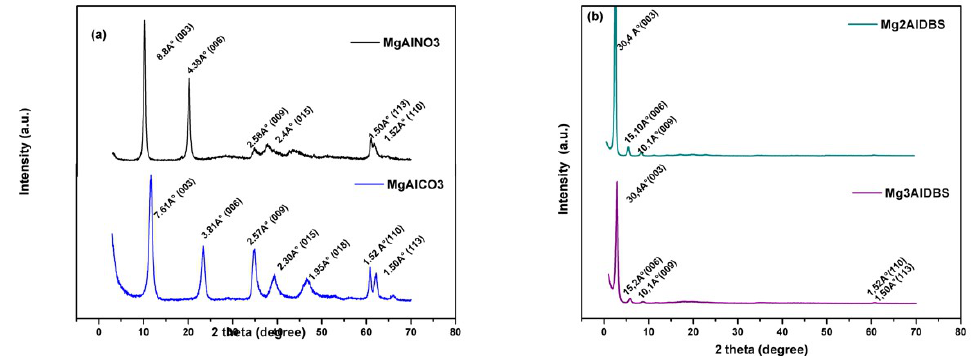
Figure 1. PXRD pattern of the synthetized adsorbents: ( a ) MgAlCO3 and MgAlNO3 LDH samples, ( b ) Mg2AlDBS and Mg3AlDBS nanohybrids samples.